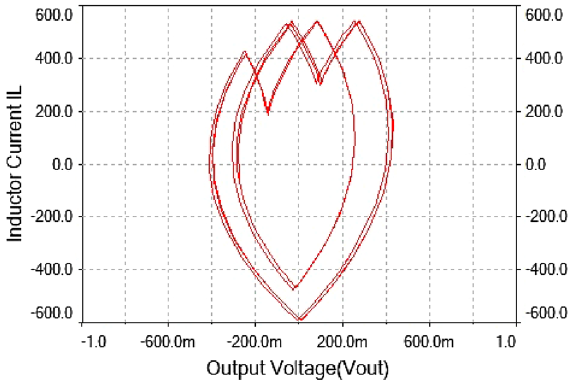
Figure 27. Phase portrait between I L vs V out at R L = 9 (cid:31) : period-4 attractor .